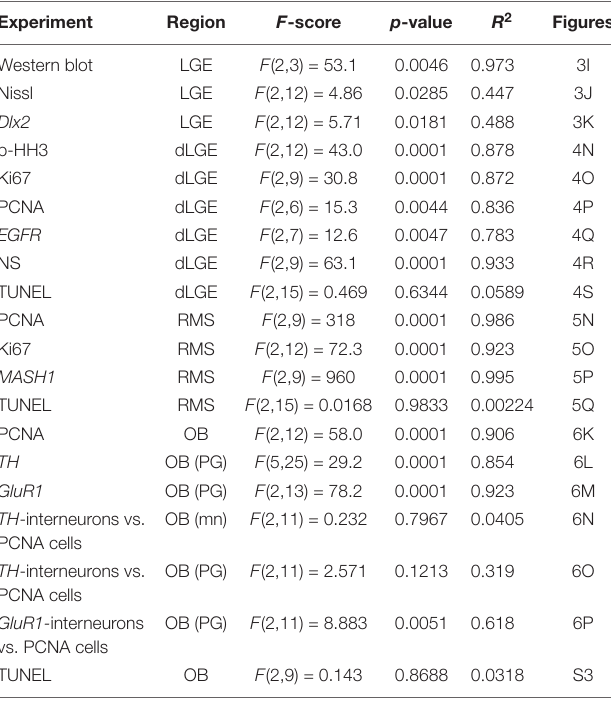
TABLE 1 | Summary of one-way ANOVA